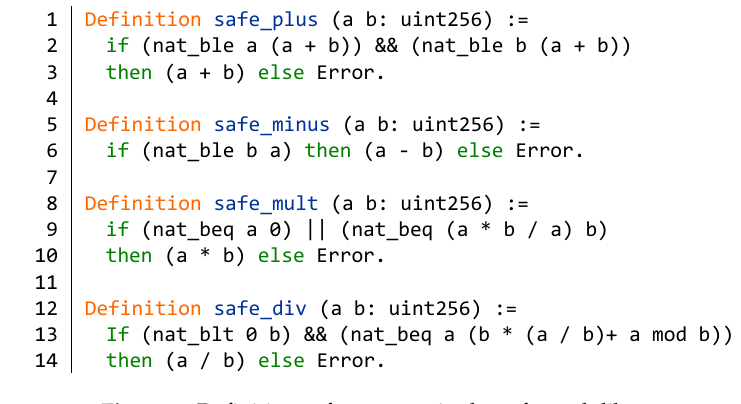
Figure 5. Definitions of operators in the safe math